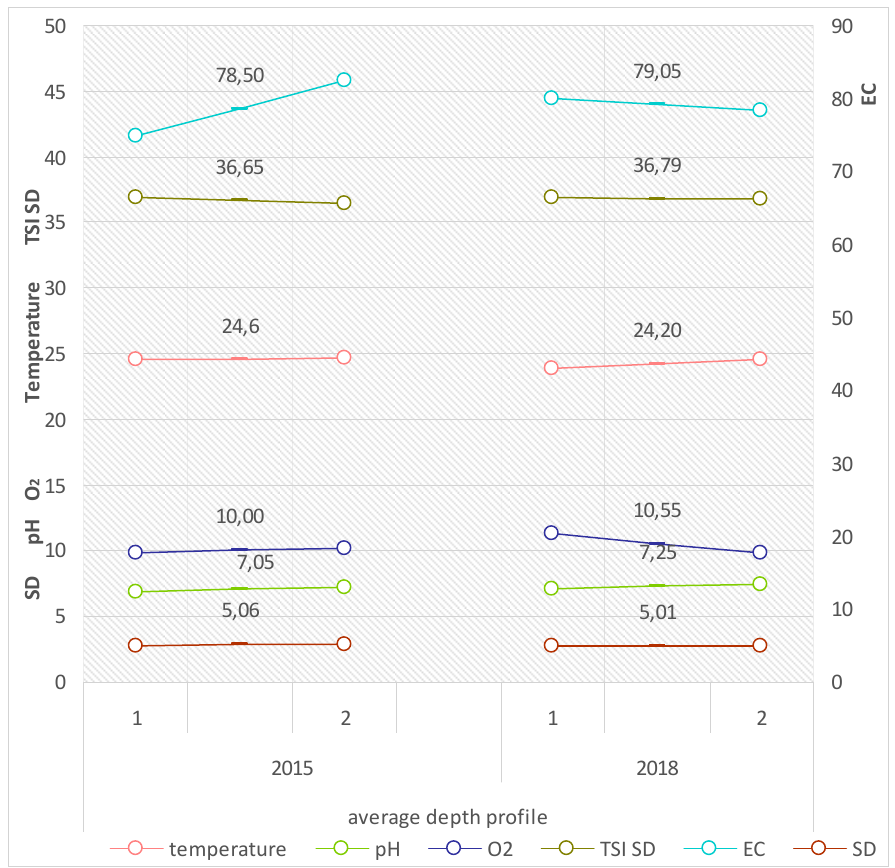
Figure 9. Mean values with ranges of physical-chemical properties of waters of the pelagial in Lake Piaseczno in the 2015 and 2018 summer seasons. O 2 , oxygen concentration (mg O 2 · dm − 3 ); temperature ( ◦ C); EC, electrolytic conductivity ( µ S · cm − 1 ); pH, reaction; SD, water transparency (Secchi Disc visibility) (m); TSI SD, Carlson’s Trophic State Index.